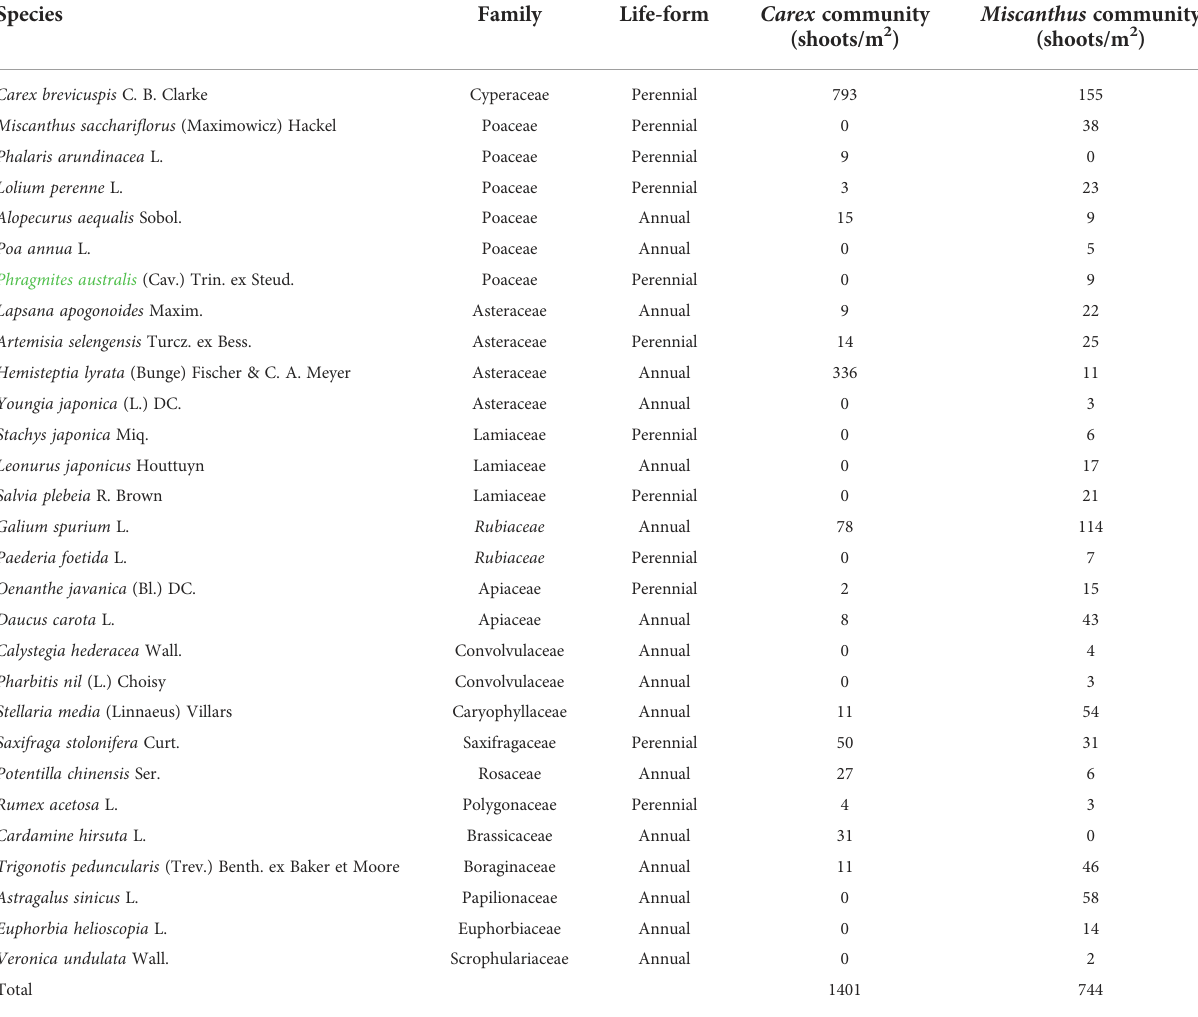
TABLE 3 Species composition and shoot density in Miscanthus and Carex communities at the Dongting Lake wetlands.